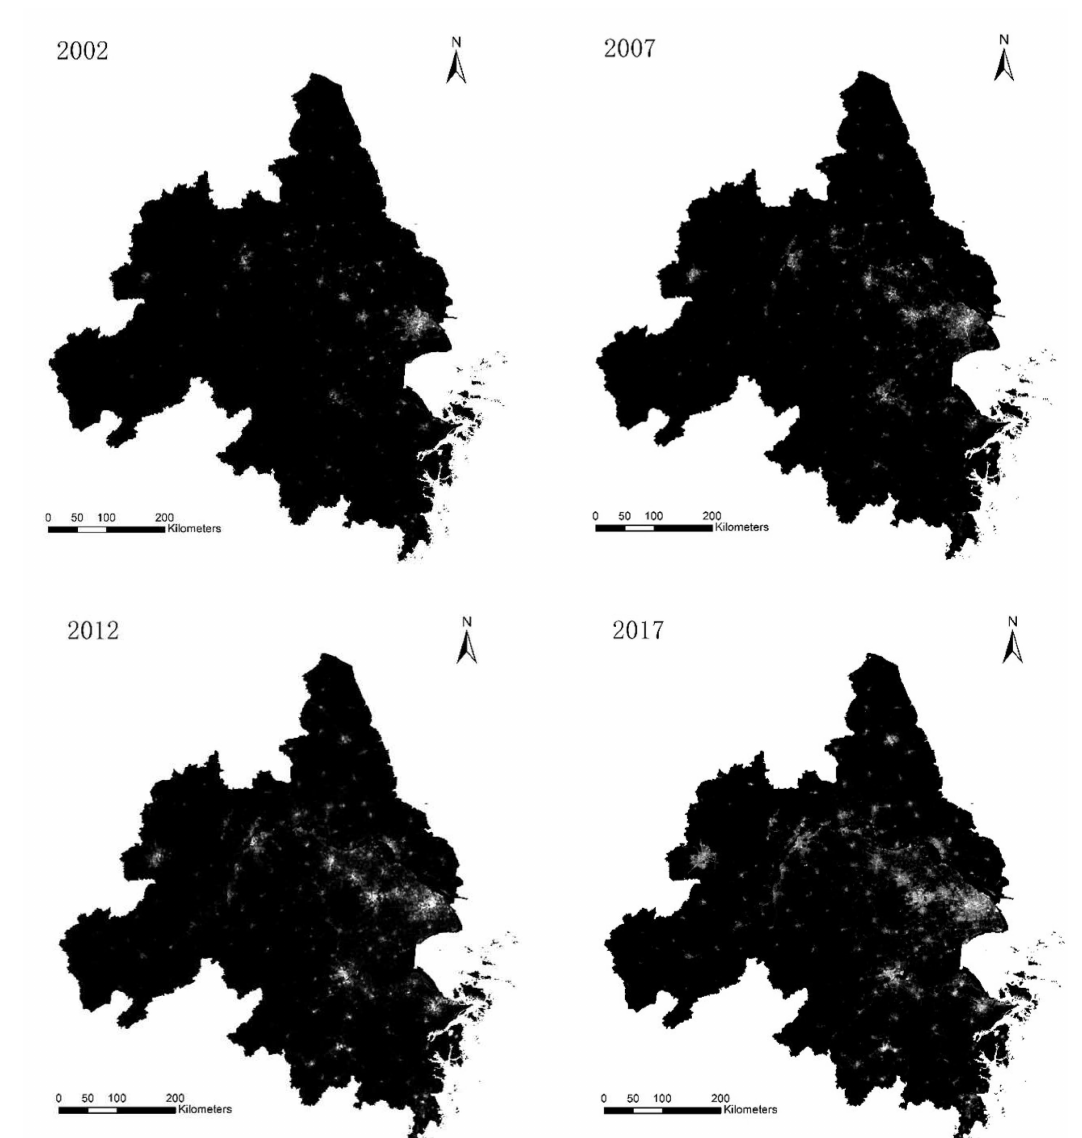
Figure 2. NPP-VIIRS-like nighttime light